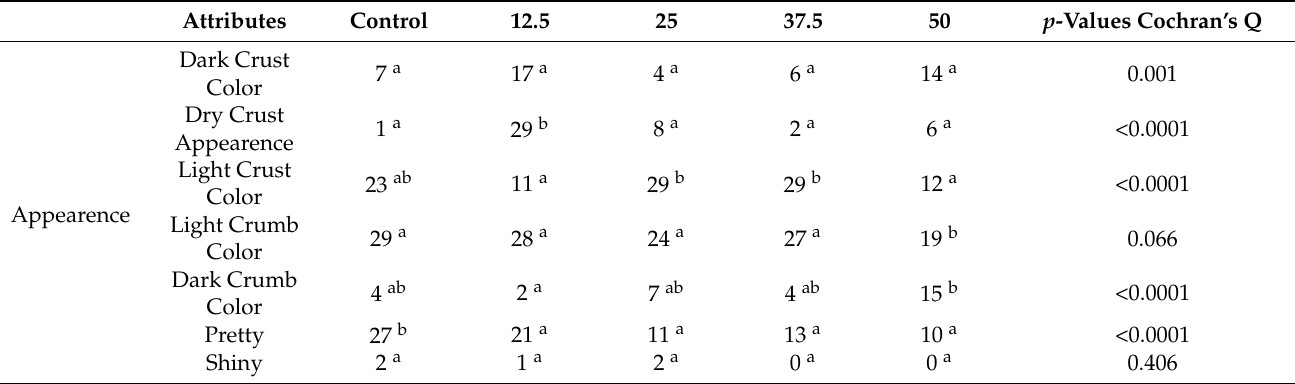
Table 4. Absolute frequencies of sensory attributes checked for the different AK gluten-free bread among frequent consumers of gluten-free bread (Group II; n =